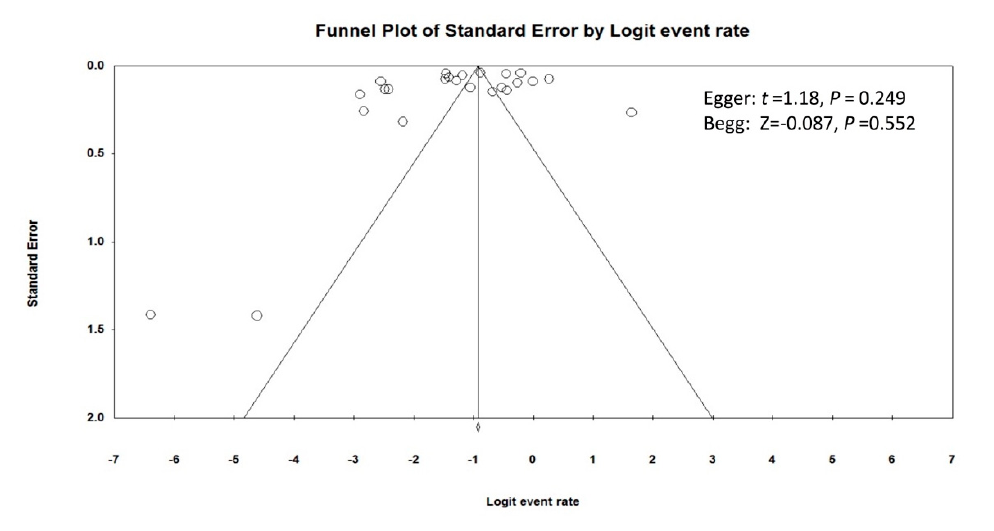
Figure 3. Funnel plot of publication bias.